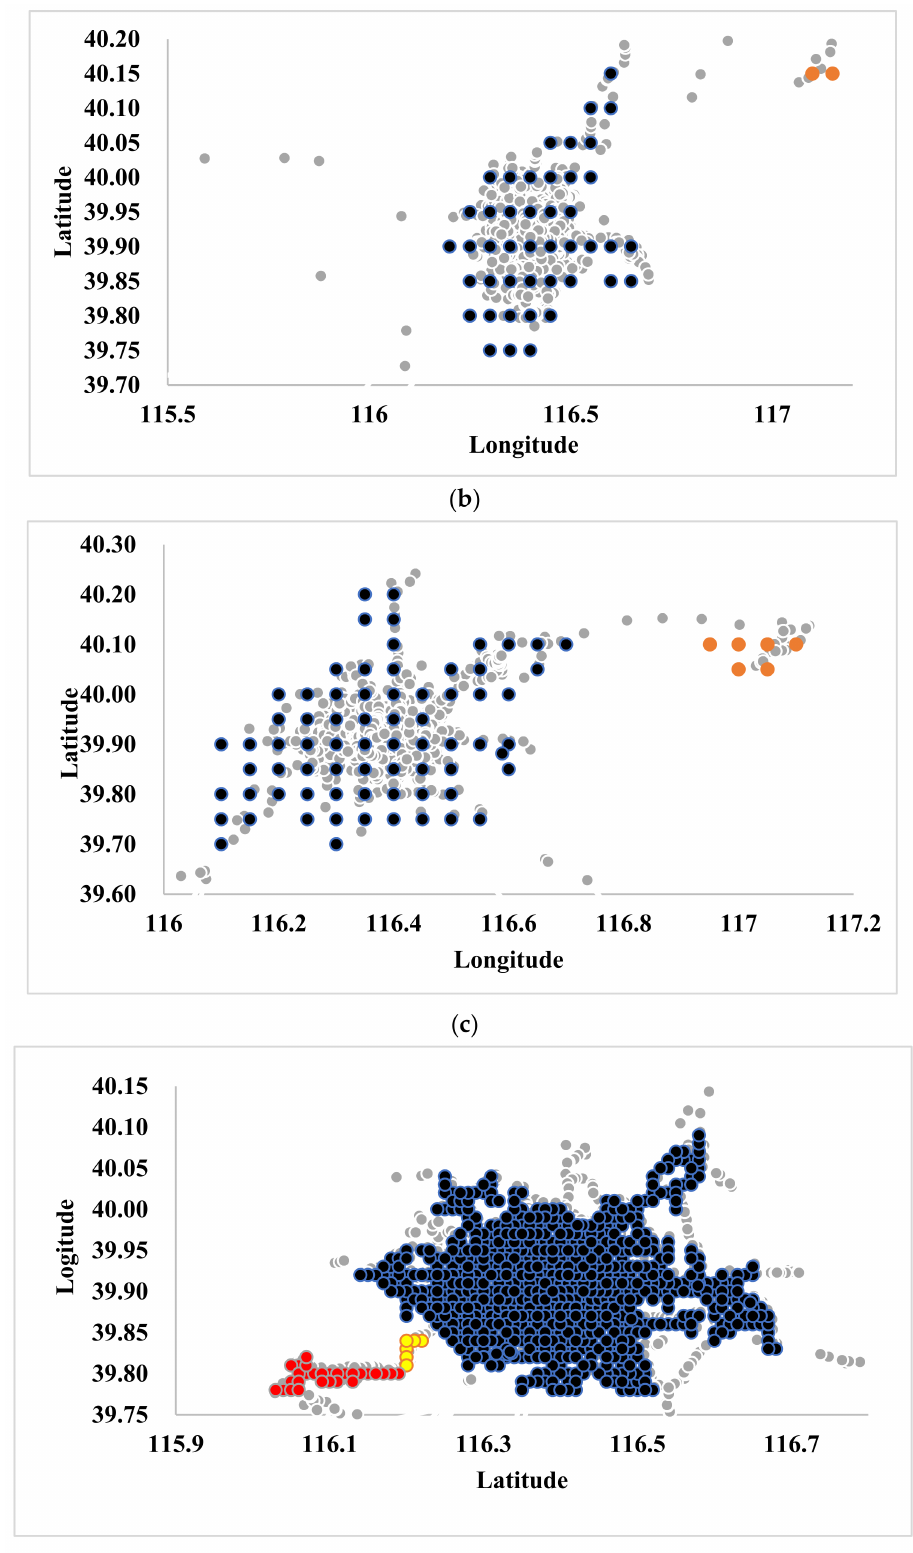
Figure 6. Visualization of clustering results on different data sets. Clustering results on ( a )